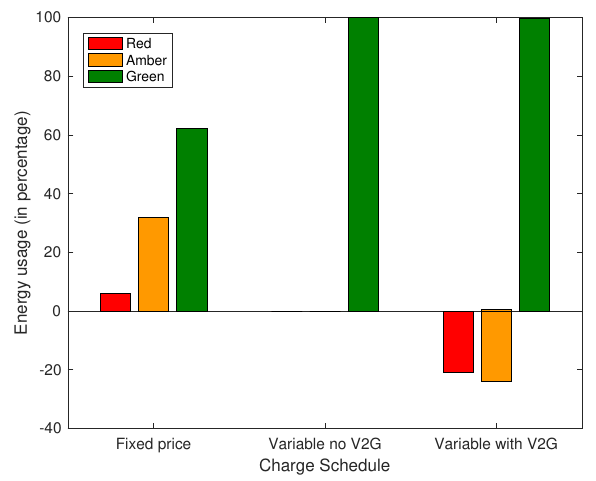
Figure 9. Energy usage across tariff regimes for pool